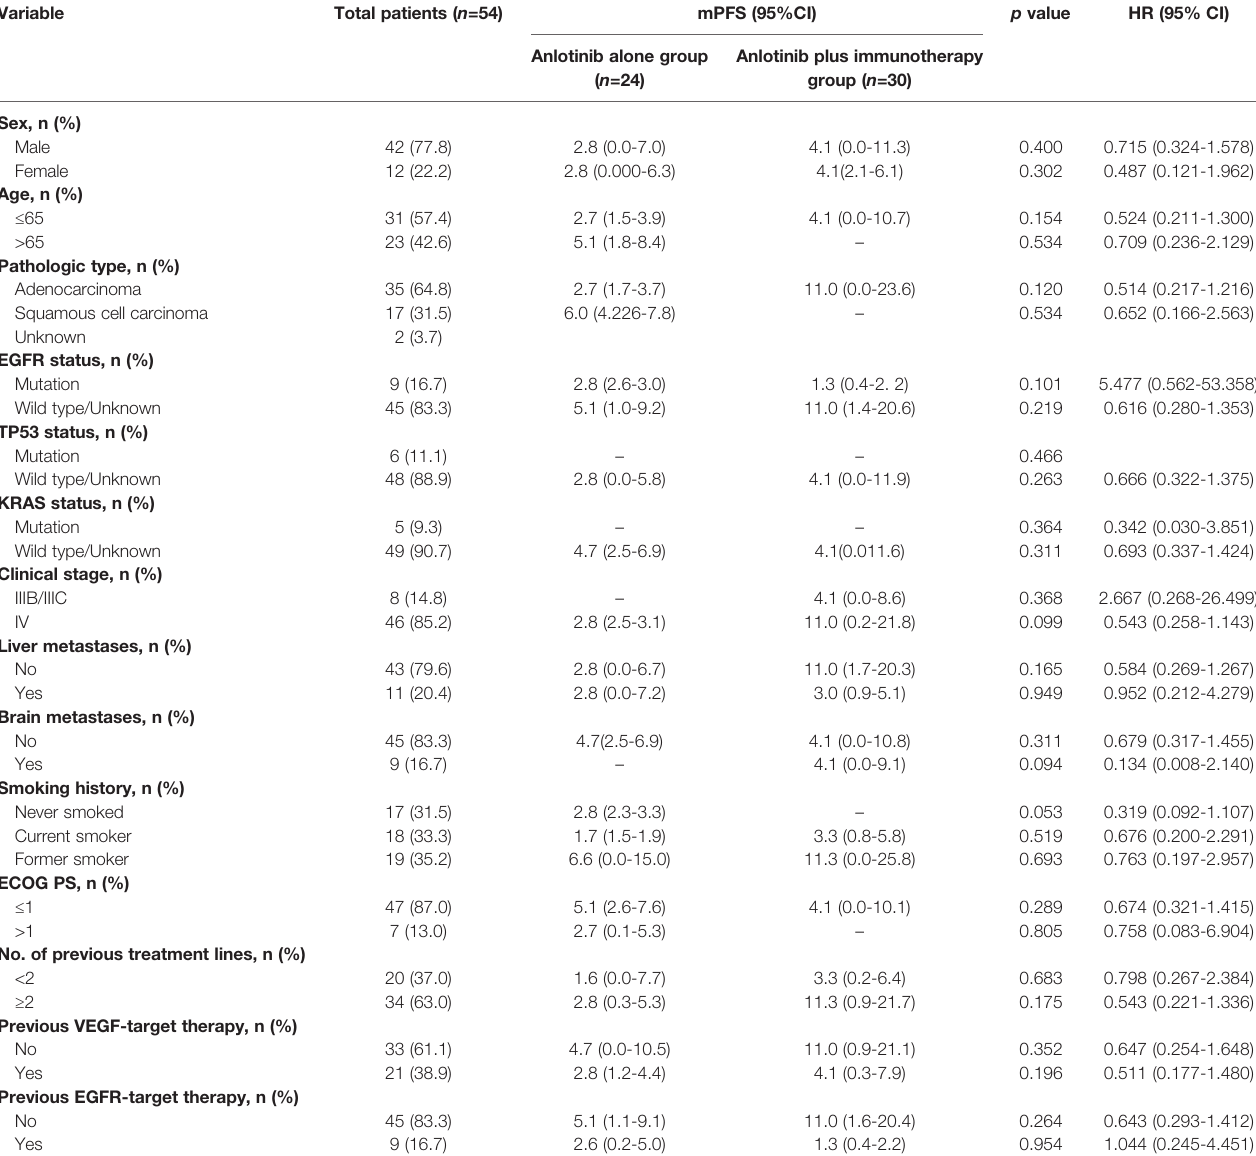
TABLE 5 | Comparison of treatment ef fi cacy between patients treated with anlotinib alone and patients treated with anlotinib plus immunotherapy. Variable